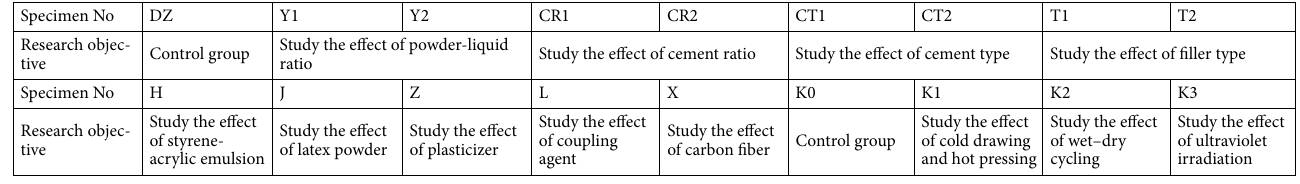
Table 2. Experimental